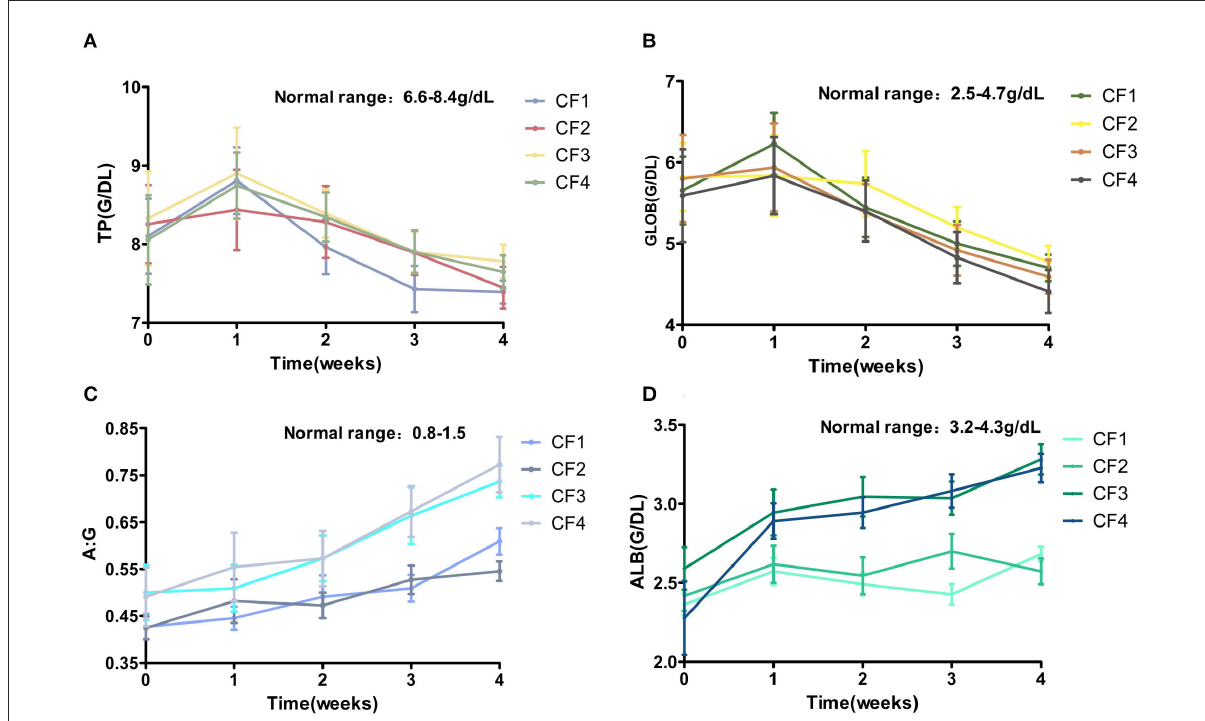
FIGURE6 Mean TP, GLOB, ALB, A:B changes and standard error for 4 groups cats that completed 4 weeks of treatment. (A) TP. (B) GLOB. (C) ALB. (D) A:G. TP, total protein; GLOB, globulin; ALB, albumin; A:G, albumin–globulin ratio.